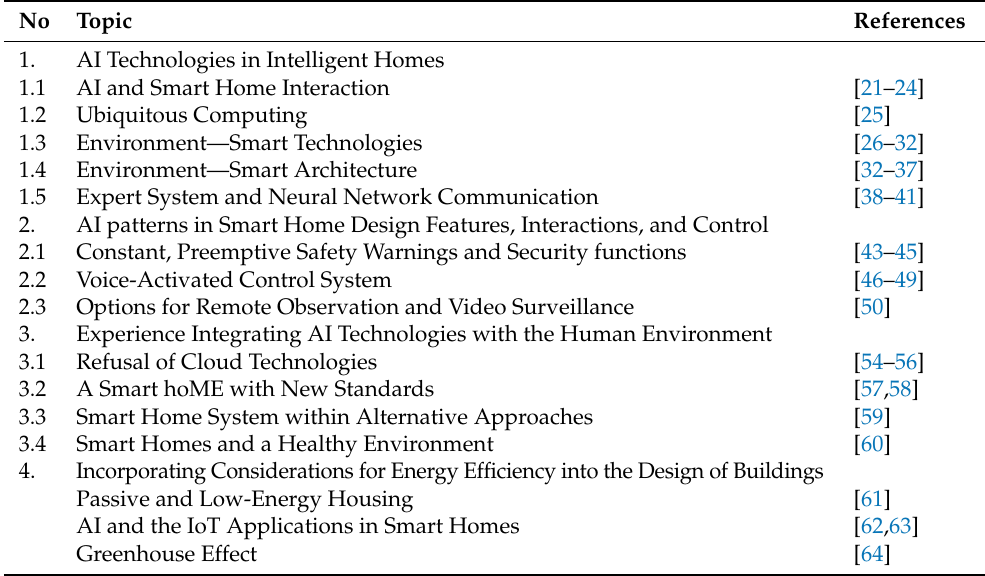
Table 1. Summary of AI Technologies, Patterns, Interactions, and Energy Efficiency in the design of Smart Buildings.